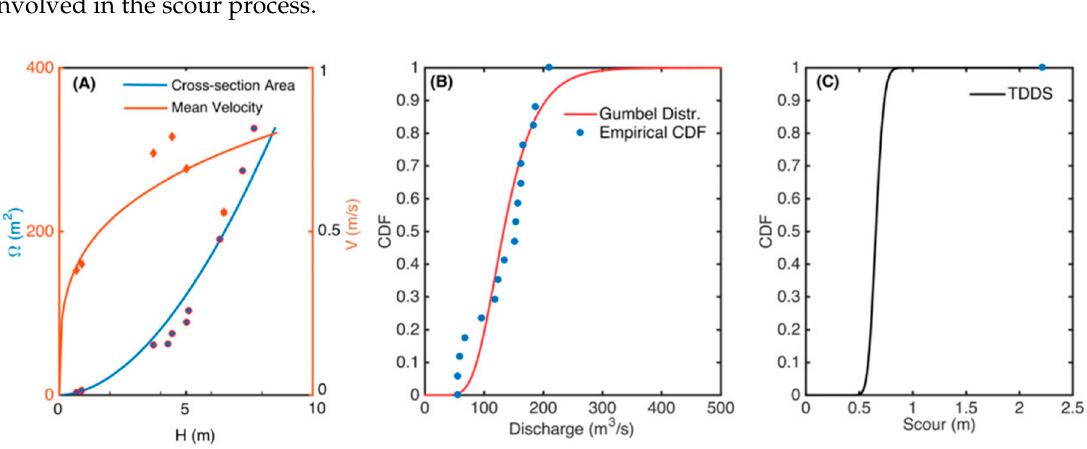
Figure 8. TDDS derived for a real study case: ( A ) Hydraulic function of velocity and cross-section area as a function of the hydraulic stage H; ( B ) cumulated probability distribution of flood annual maxima; ( C ) cumulated probability distribution of scour of the Basento River at SS106.